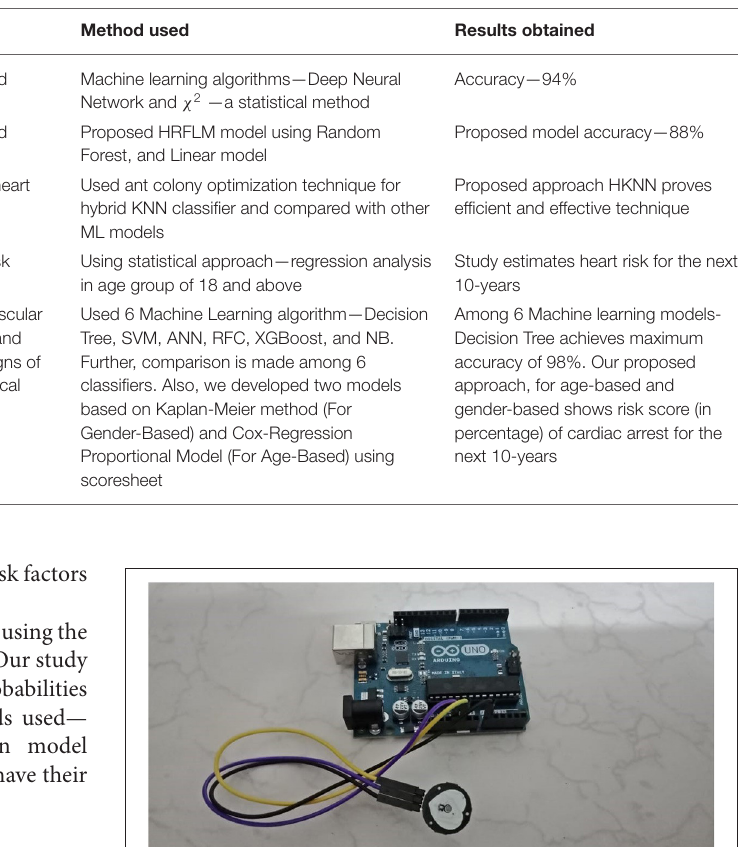
TABLE 1 | Comparison of literature work and proposed work.